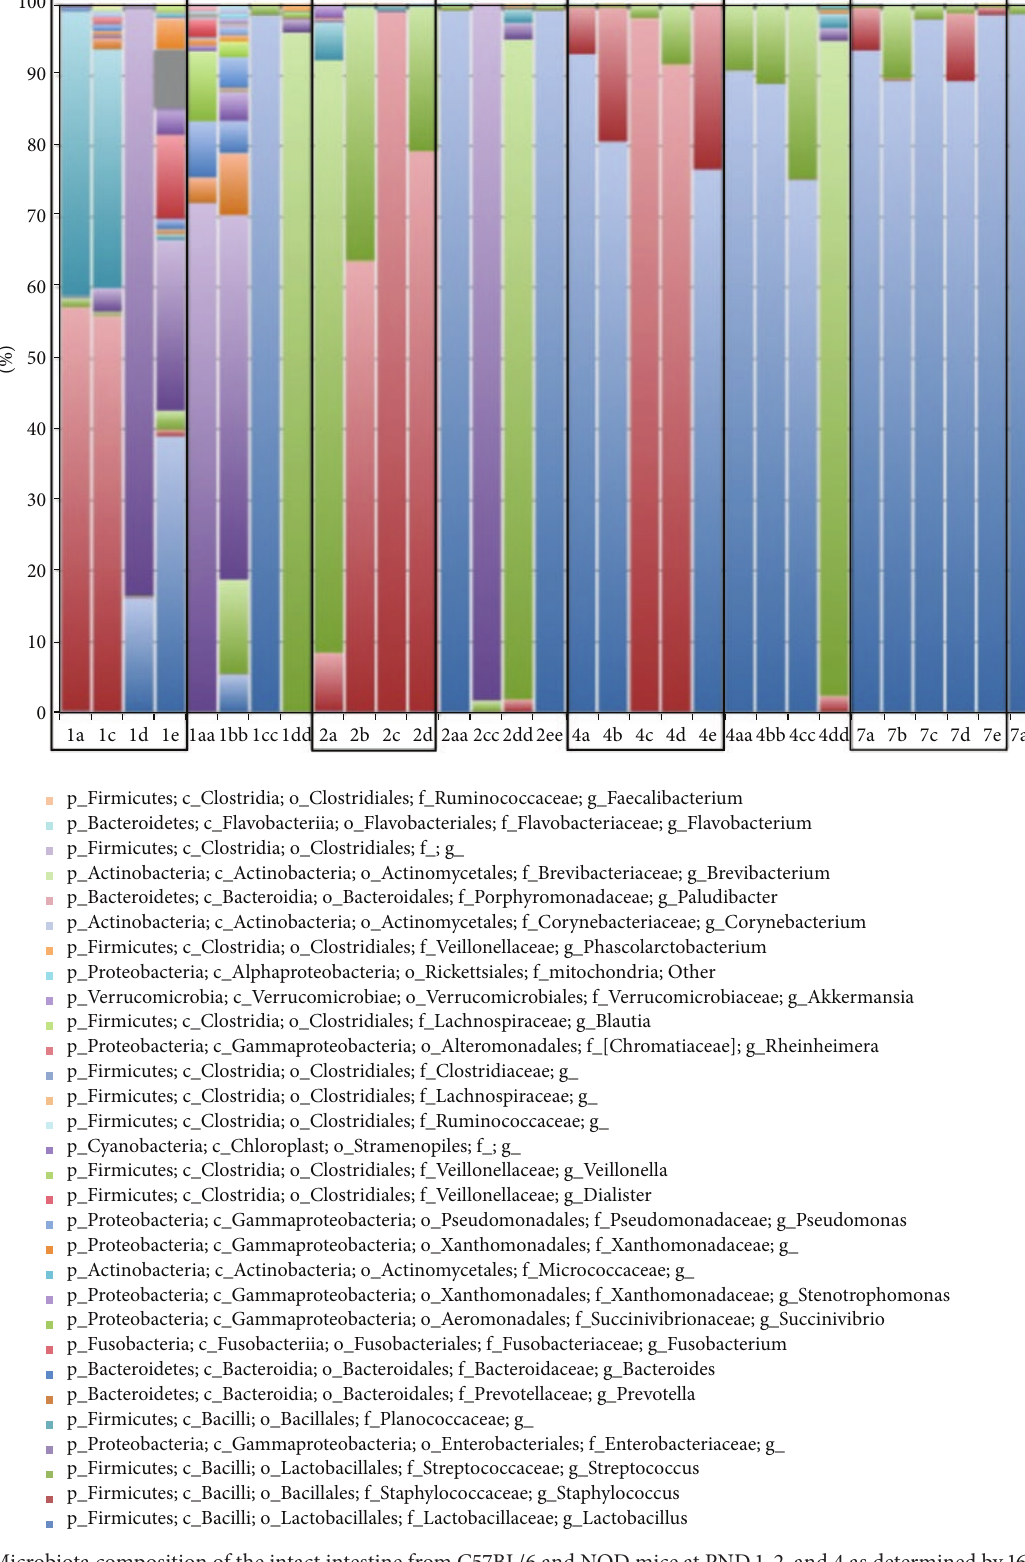
Figure 9: Microbiota composition of the intact intestine from C57BL/6 and NOD mice at PND 1, 2, and 4 as determined by 16S rRNA gene amplicon high throughput sequencing. Brackets indicate phylum . Red : Staphylococcus (g) (Firmicutes). Blue : Lactobacillus (g) (Firmicutes). Purple : Enterobacteriaceae (f) (Proteobacteria). Green : Streptococcus (g) (Firmicutes). Turquoise : Planococcaceae (f) (Firmicutes). Black boxes indicate NOD mice